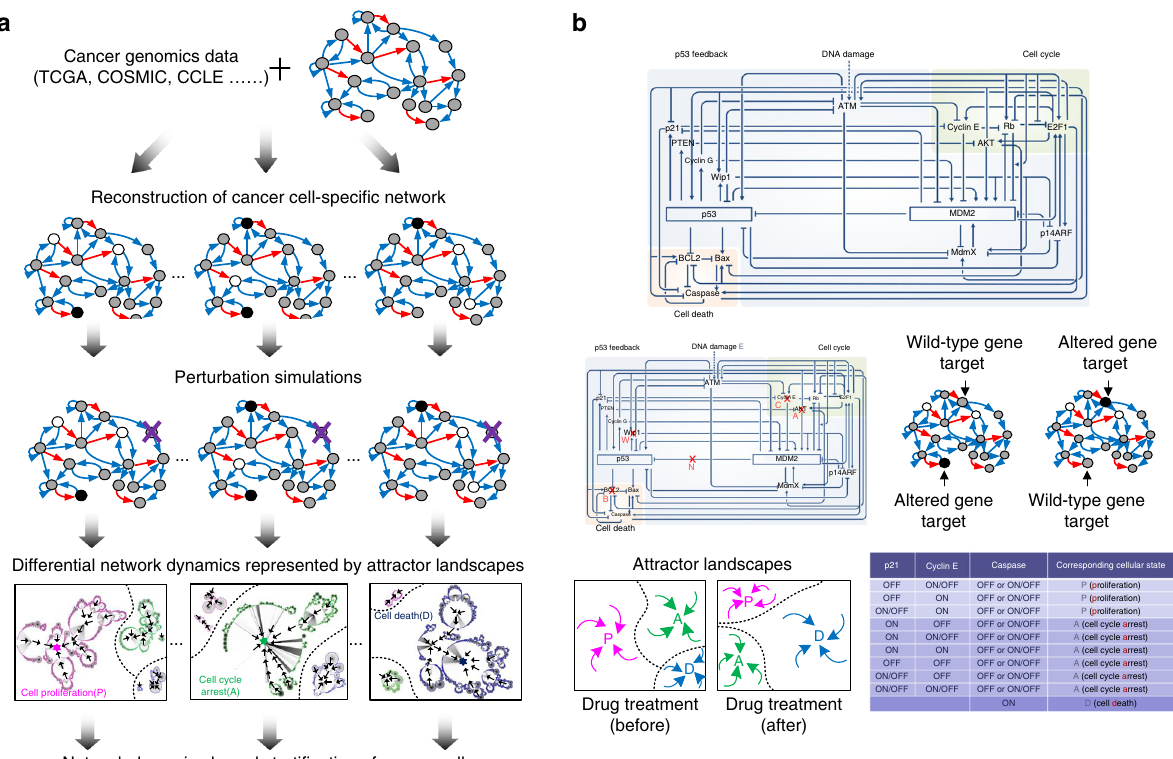
Fig. 1 Network dynamics-based strati fi cation of cancer cells using attractor landscape analysis of network dynamics and application to p53 network. a Cancer cells are represented as differentially wired networks that have a distinct network topology by mapping functional genomic alterations in cancer cells onto the nominal network. Network dynamics induced by the perturbation can be analyzed by an attractor landscape, which consists of the trajectories from all possible initial states to the attractor states. Different cancer cells eventually reach the attractor states that correspond to speci fi c cellular phenotypes. The area around each attractor state is the region of states with trajectories going to the attractor, which is called the “ basin of attraction ” or “ basins ” , and can be used for measuring the relative ratio of the speci fi c cellular phenotypes, including cell proliferation (P), cell cycle arrest (A), and cell death (D). Final strati fi cation of the differentially wired network is obtained based on differential network dynamics in response to perturbation. The node color represents the status of the node activity. For example, a black (white) node means that the node is constantly activated (inactivated) and a gray node means that the status is dependent on the activity of a given input. b The p53 network is modeled as a simpli fi ed Boolean network, consisting of 16 nodes with multiple feedback loops through p53 (upper panel). We chose to analyze p53 network in response to perturbation of fi ve druggable network nodes/links (left, middle panel: AKT (A), BCL2 (B), Cyclin E (C), Wip1 (W), and p53-MDM2 (N)), with/without a DNA-damaging reagent, Etoposide (E). The selected target nodes were further divided into two classes: one corresponds to altered gene in the network that is constantly activated or inactivated and the other corresponds to wild-type gene (right, middle panel). To evaluate drug response variation, we de fi ned the viable cellular phenotypes based on attractor states (lower